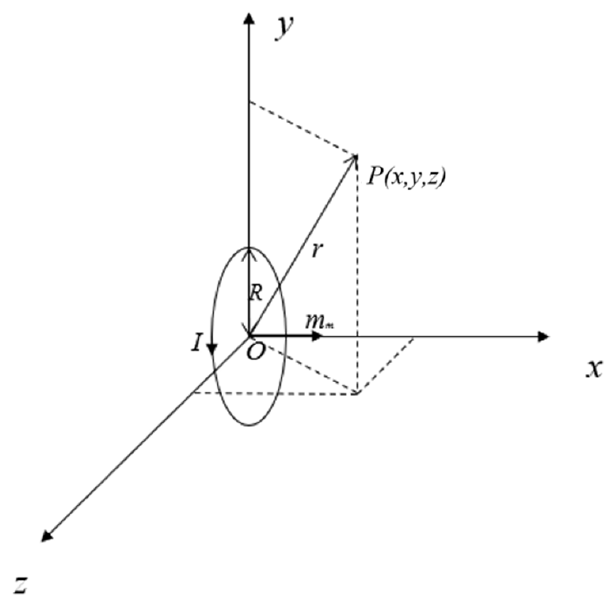
Figure 1. A magnetic dipole with the magnetic moment along the x-direction.